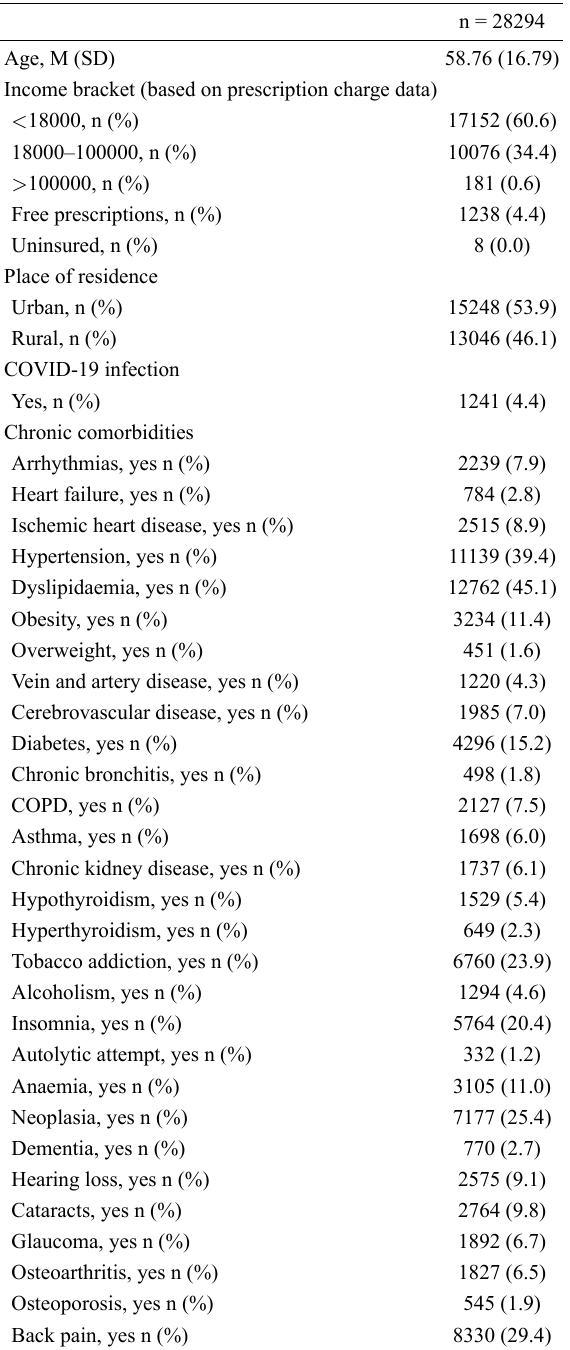
Table 1. Sociodemographic data, chronic comorbidities and COVID-19 infection in patients suffering from anxiety or depression in Aragon at least 6 months prior to the pandemic outbreak. n = 28294 58.76